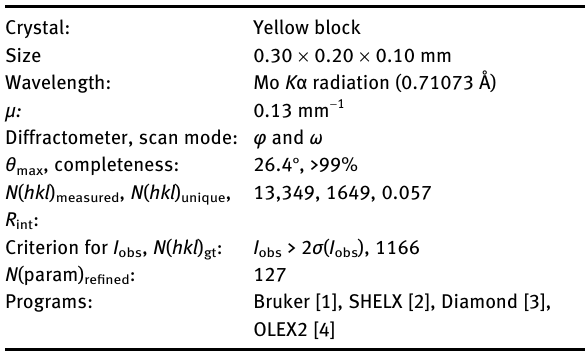
Table  : Data collection and handling.